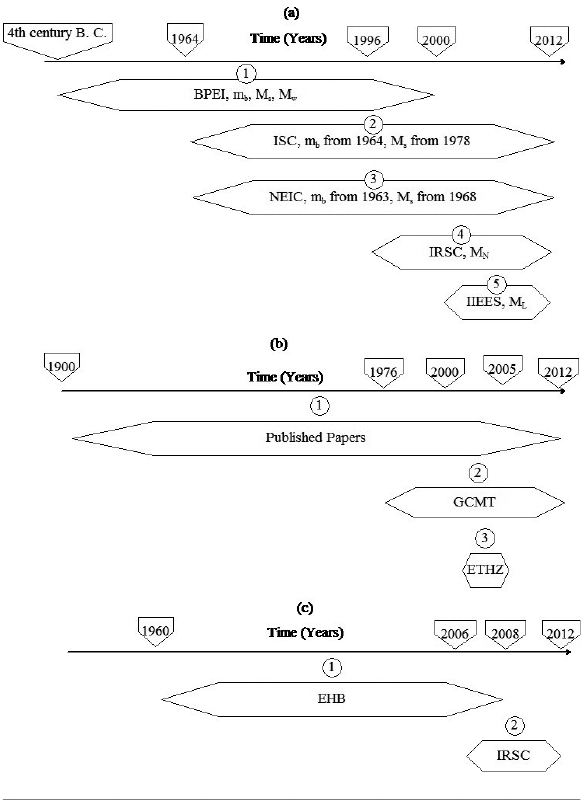
Figure 2. Priority order of data selection from various agencies. (a) Preparing the master catalog, (b) adjoining moment magnitude, (c) optimizing the location of events. See text for description of ab-